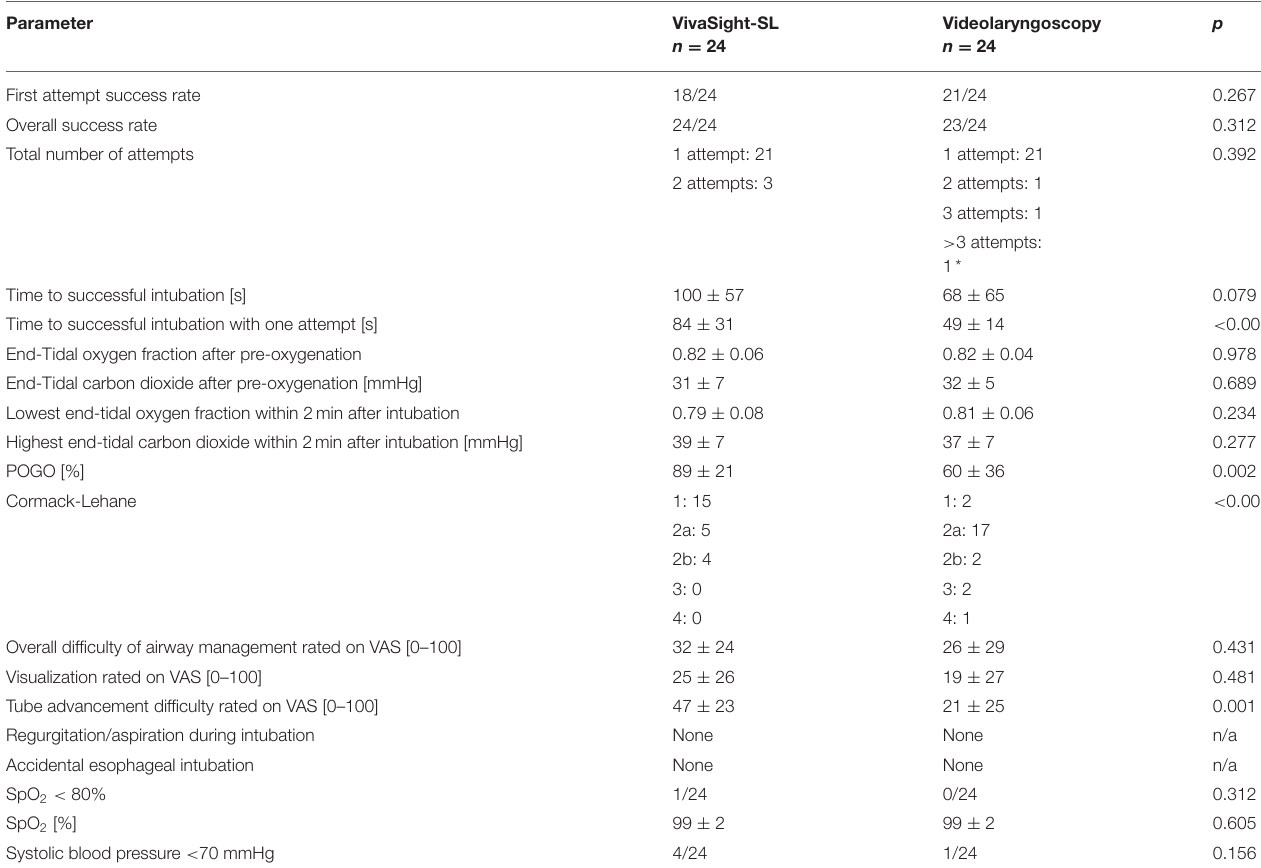
TABLE 2 | Outcome parameters.